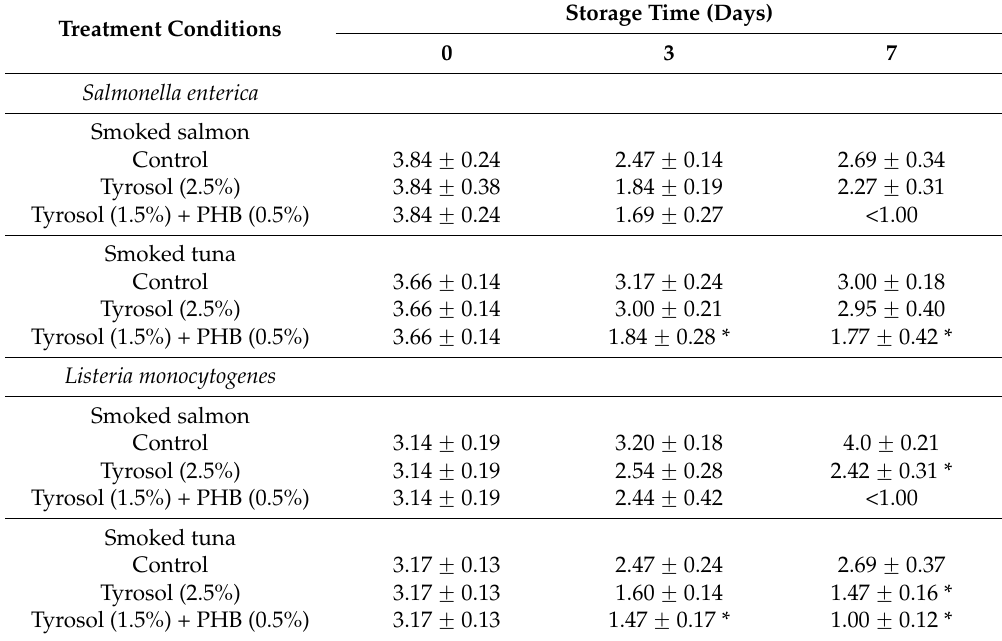
Table 3. Survival of Listeria monocytogenes and Salmonella enterica strains inoculated on smoked tuna and smoked salmon vacuum packaged in low density polyethylene films activated or not with tyrosol singly or in combination with p -hydroxibenzoic acid (PHB). Samples were stored at 4 ˝ C for 7 days. Storage Time (Days) Treatment Conditions 0 Salmonella enterica Smoked